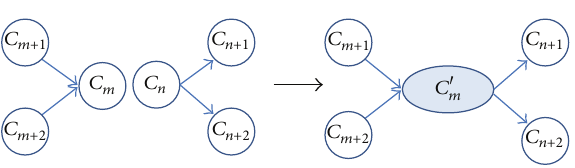
Figure 4: Parallel merging operator.